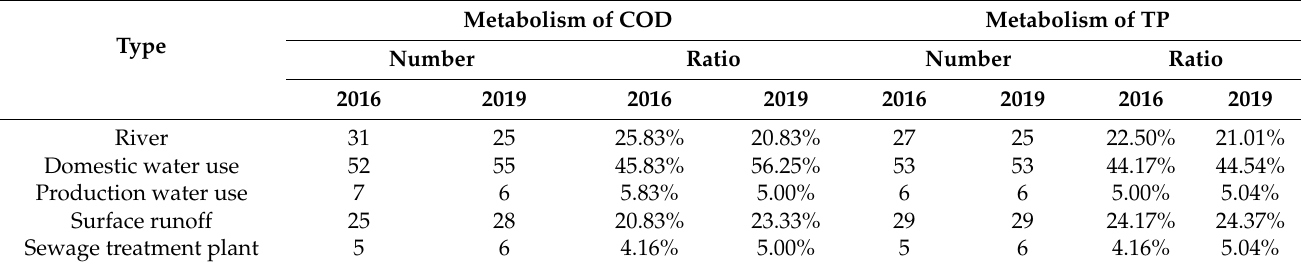
Table 9. Number and ratio of the competition ecological relationship for five compartment